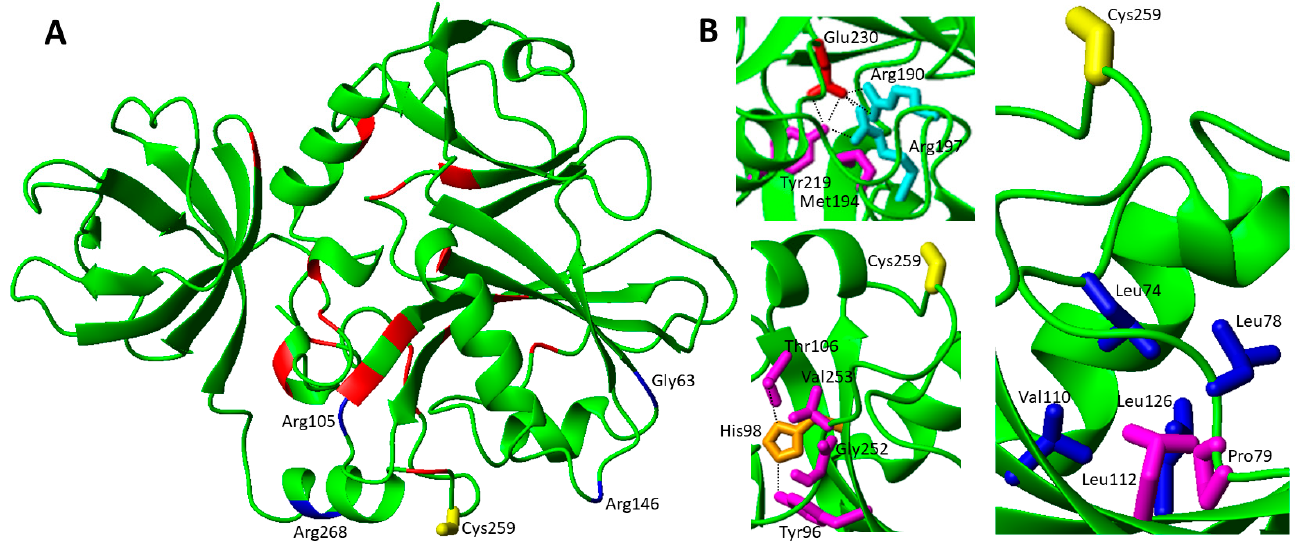
Figure 5. Pathogenic missense mutations mapped on the crystallographic structure of human IBA57. ( A ) The backbones of the buried and solvent-accessible residues involved in pathogenic missense mutations of IBA57 are colored in red and blue, respectively, on the ribbon structure of IBA57 (PDB ID 6QE4). The sidechain of the conserved cluster coordinating Cys259 is shown in yellow. ( B ) The sidechains of the residues involved in pathogenic missense mutations are shown in magenta. Hydrogen bond interaction is shown as a dotted black line. The positively charged, negatively charged and hydrophobic residues interacting with the residues shown in magenta are shown in cyan, red and blue, respectively.